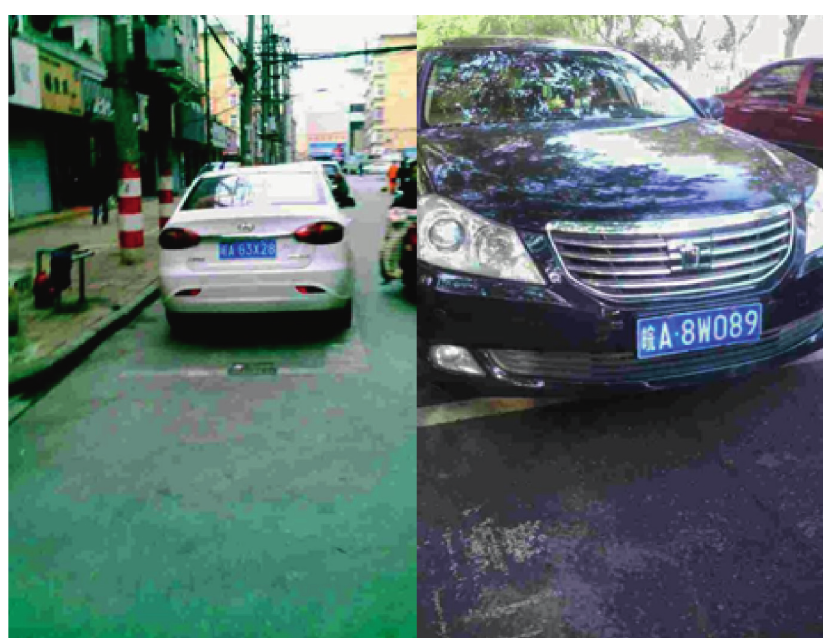
Figure 14: Sample picture of CCPD dataset [14].